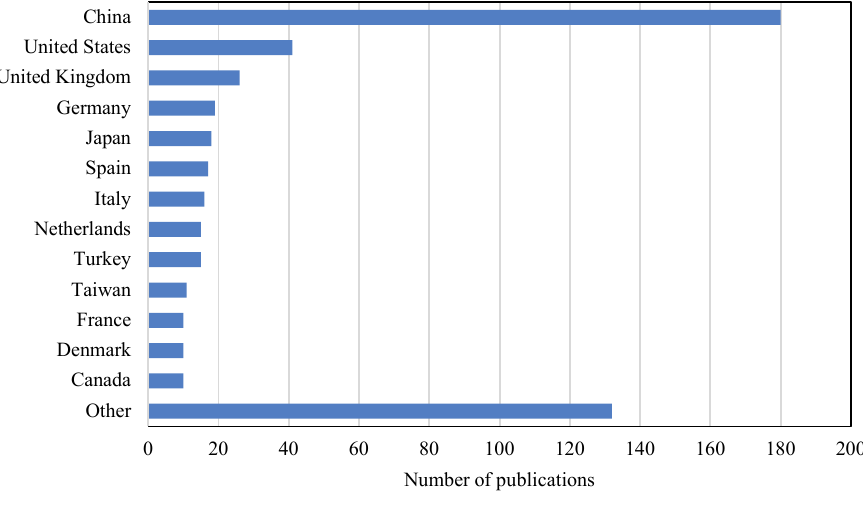
Fig. 4. Overall trend in the countries of publications for all